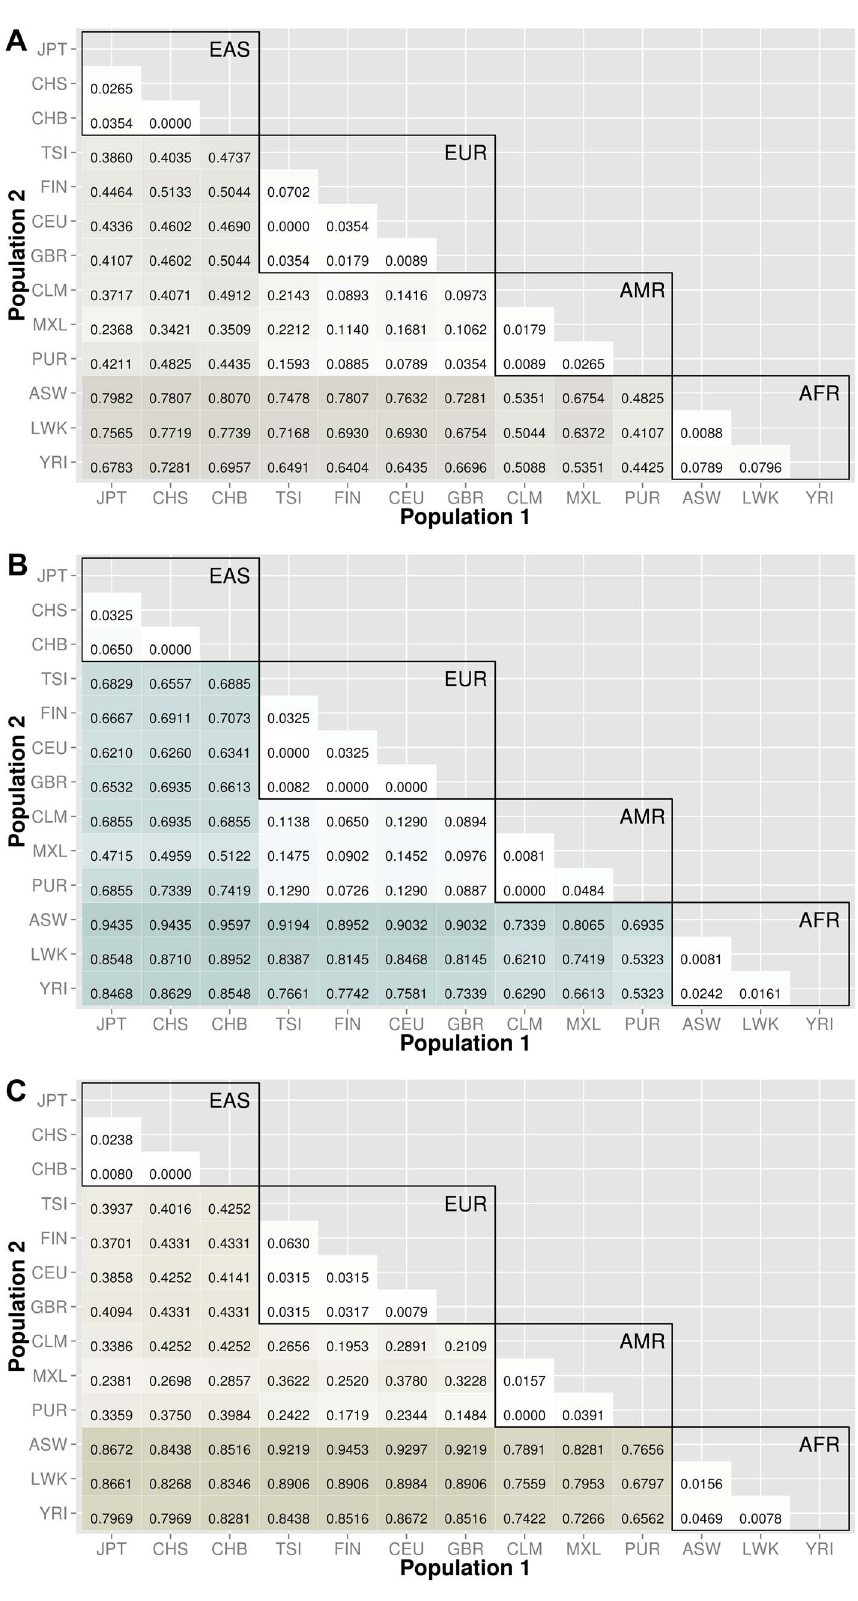
Figure 6. Proportion of significantly different bins in natural selection analysis by region of identification: A) AFR continental group, B) EAS continental group, and C) EUR continental group. The abbreviations for the each population on are on the x and y-axes. The numbers in each block and the color intensity [0,1] indicate the proportion of significant bins (after Bonferroni correction) for the 1000 Genomes populations on each axis, where the darker the color, the higher the proportion of significant bins. In general, the x-axis is organized with African